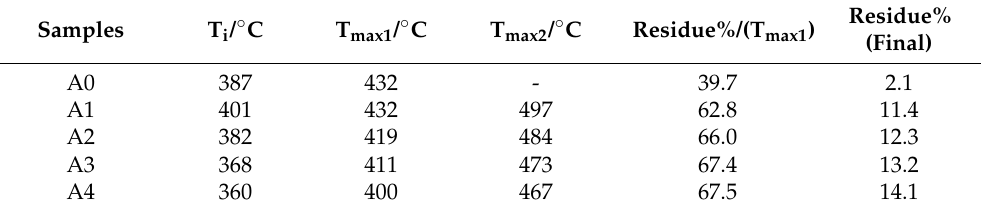
Table 2. The TGA and DTG detail of FR-PA66.